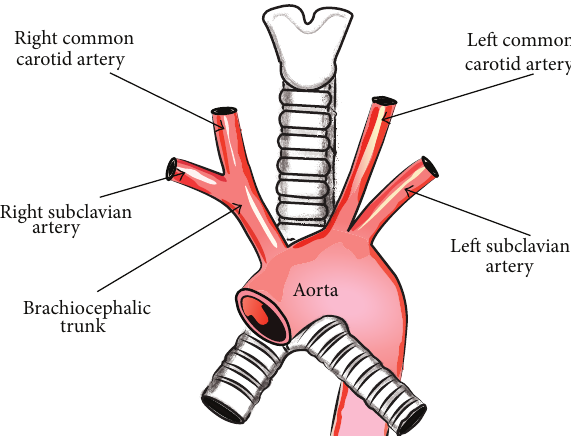
Figure 1: Schematic arrangements of the more common morphological variations of branches of the aortic arch.